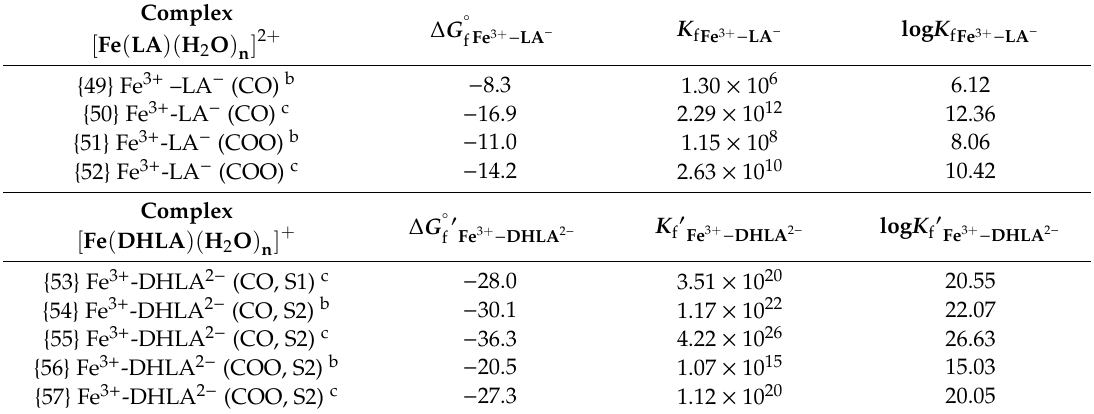
Table 4. Standard Gibbs free energy change ( ∆ G the non-octahedral chelation of Fe(III) with LA − (as per Equation (4)), and with S1- and S2-deprotonated DHLA 2 − (as per Equation (7)) in aqueous solution at 298.15 K. a